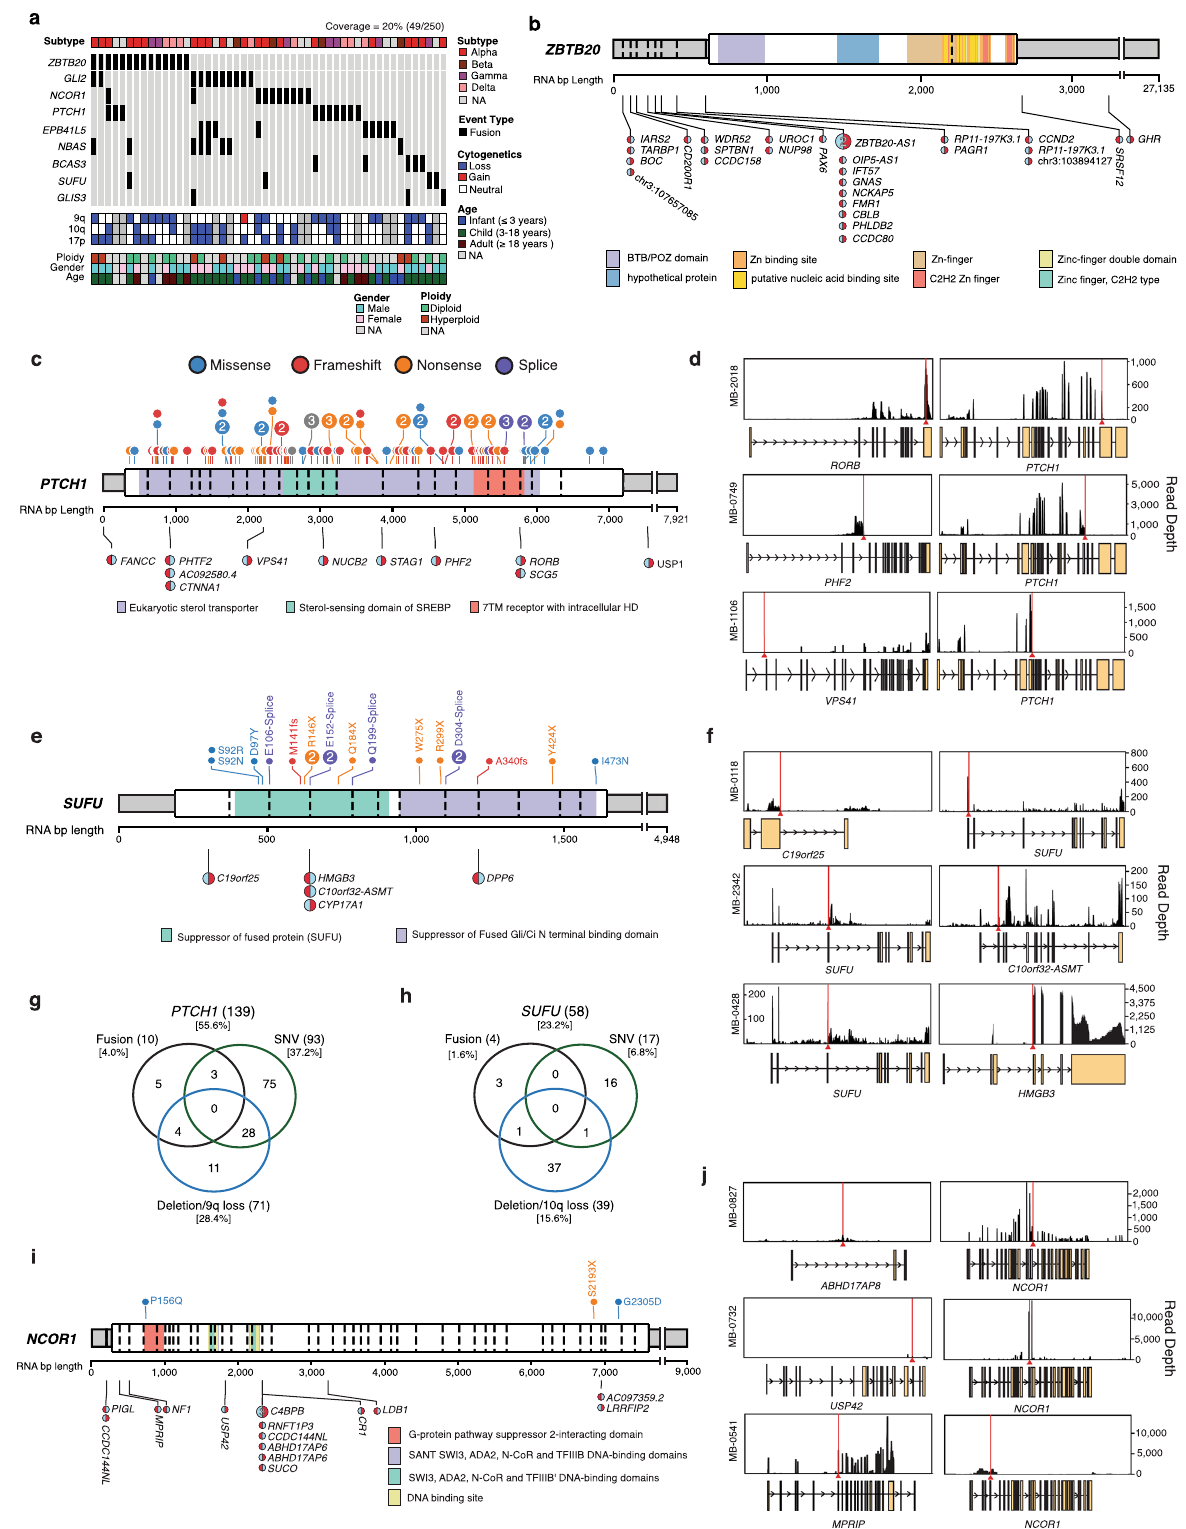
Fig. 6 Recurrent fusions in Shh-MB. a Oncoprint of fusions detected in focally ampli fi ed regions and known Shh-MB tumor suppressors. NA, not available. b Gene-level summary of ZBTB20 events. Mutations are shown as lollipop diagrams above the gene schematic and fusion events are shown below. The 5 prime and 3 prime orientation of the fusion transcript is indicated by the color orientation. In cases where ZBTB20 is the 3 prime partners, the fusion lollipop is red on the right. c Gene-level summary of PTCH1 events. d Read depth diagrams of representative PTCH1 fusion events. e Gene-level summary SUFU events. f Read depth diagrams of representative SUFU fusion events. g Overlap of PTCH1 fusion, ampli fi cation, and mutation events. h Overlap of SUFU fusion, ampli fi cation, and mutation events. I Gene-level summary of NCOR1 events. j Read depth diagrams of representative NCOR1 fusion events.